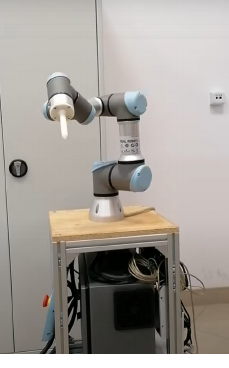
Figure 13. Snapshot of test 3.